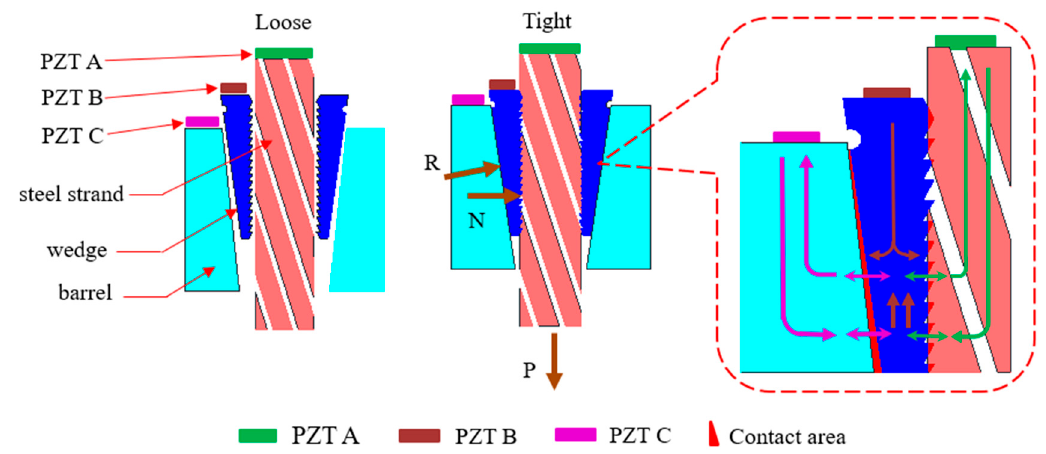
Figure 12. Energy transfer diagram of wedge anchorage.